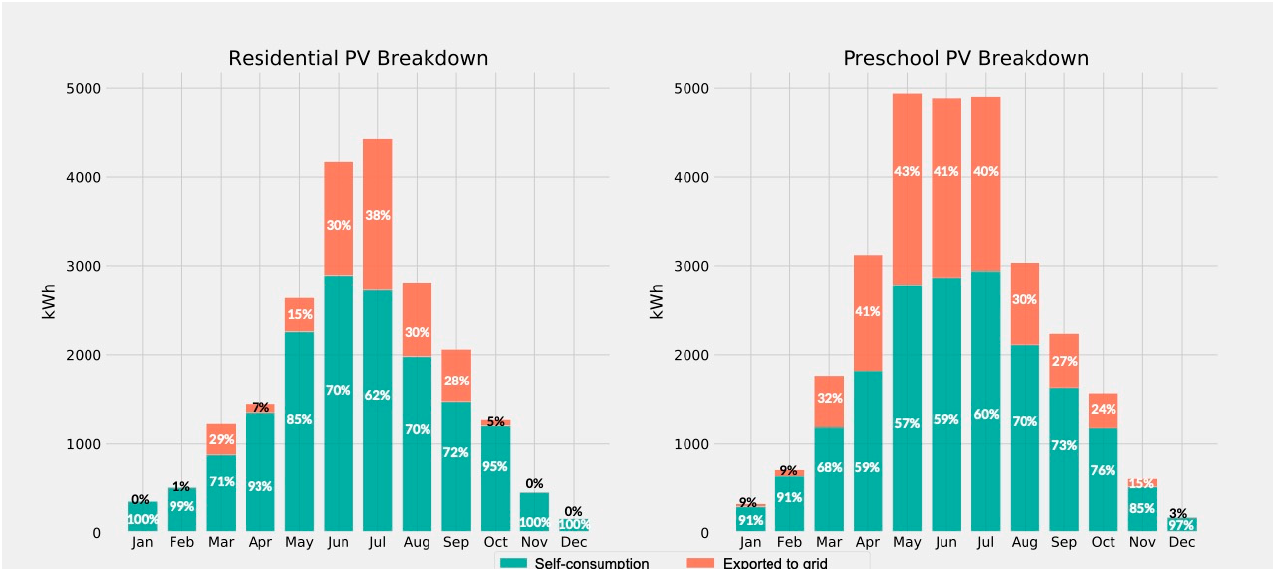
Figure 5. Monthly breakdown of electricity produced from PV system into self-consumed electricity (green) and electricity exported to the synchronous grid (orange).